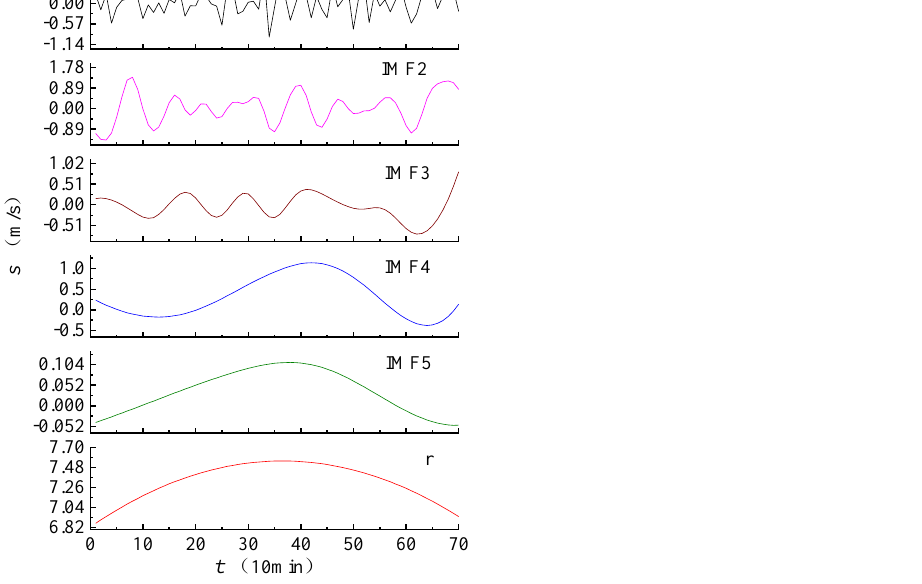
Figure 10. Ensemble empirical mode decomposition results of the first 70 points of the wind speed series.